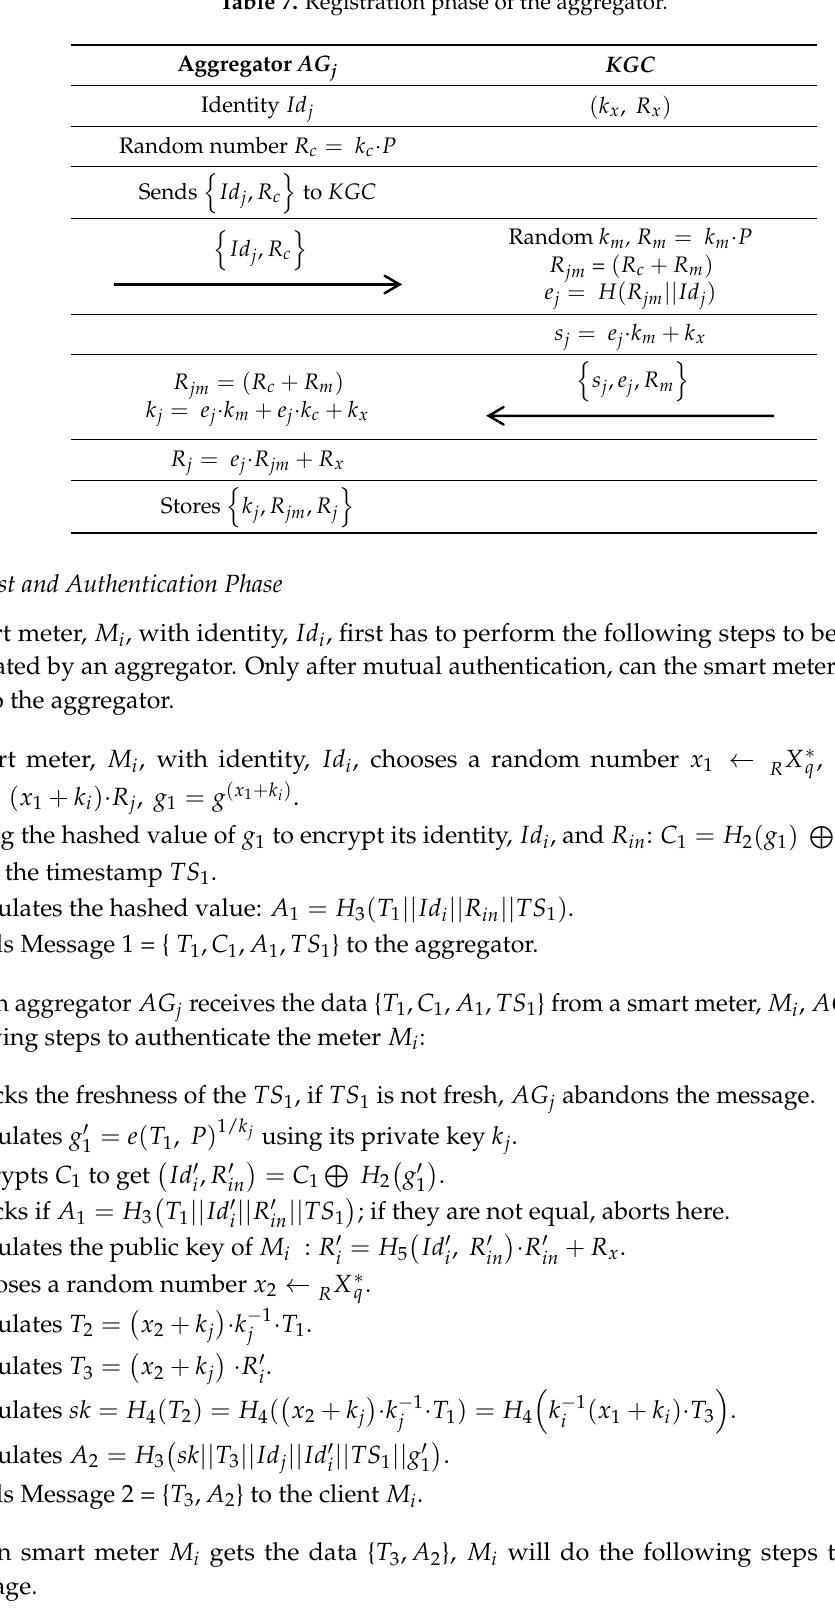
Table 8. Request and authentication phase of the proposed Table 7. Registration phase of the aggregator.